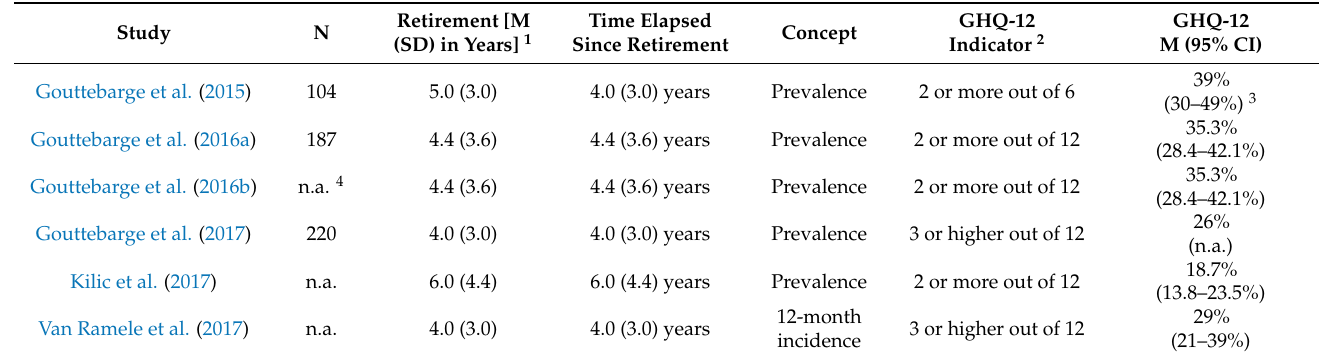
Table 1. Former professional soccer players’ mental health